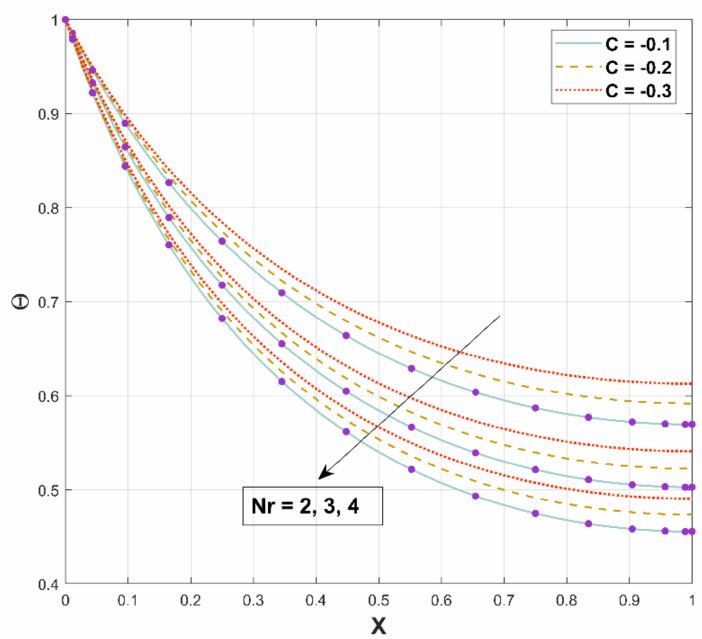
Figure 7. Upshot of Nr on Θ .